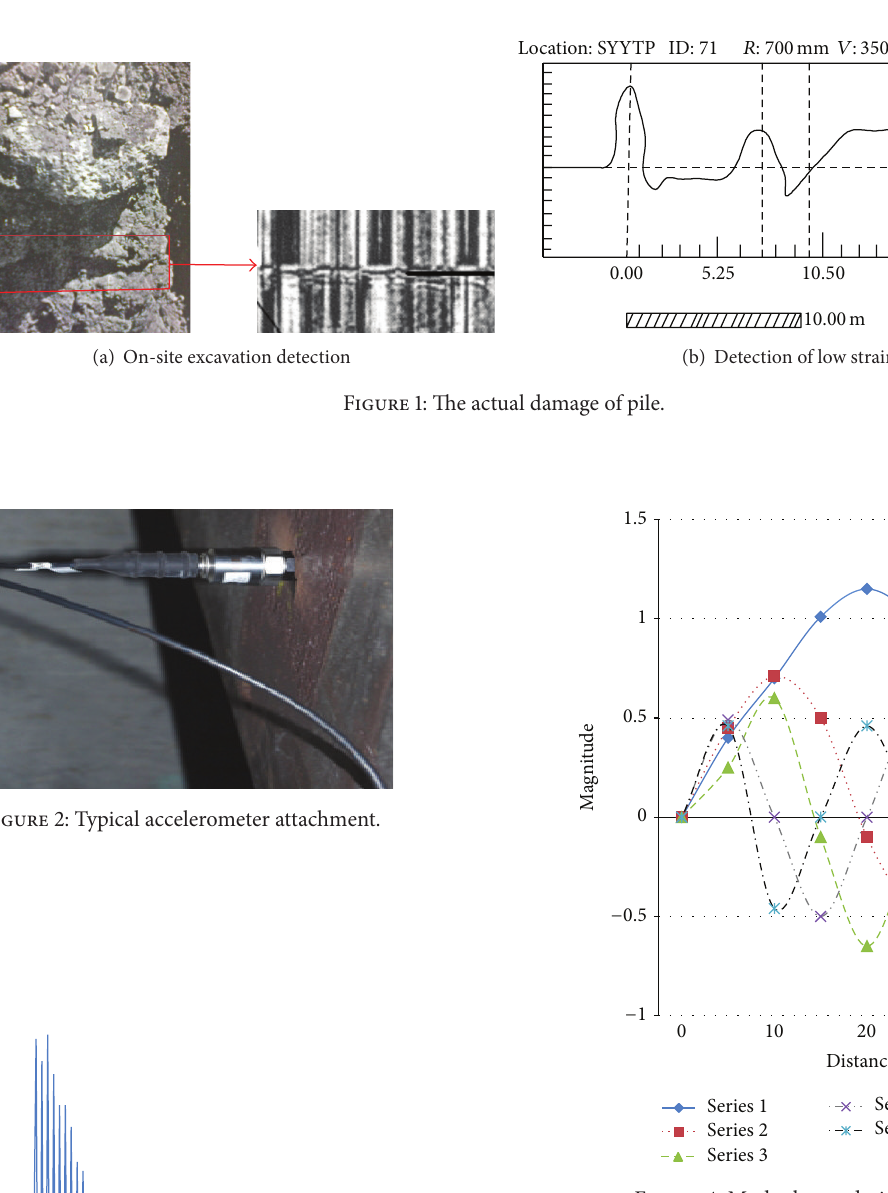
Figure 4: Mode shapes derived by